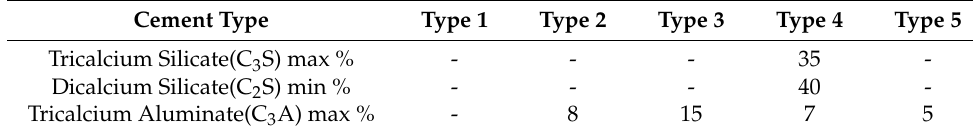
Table 2. Standard composition ratios of the cement types as defined in ASTM C150